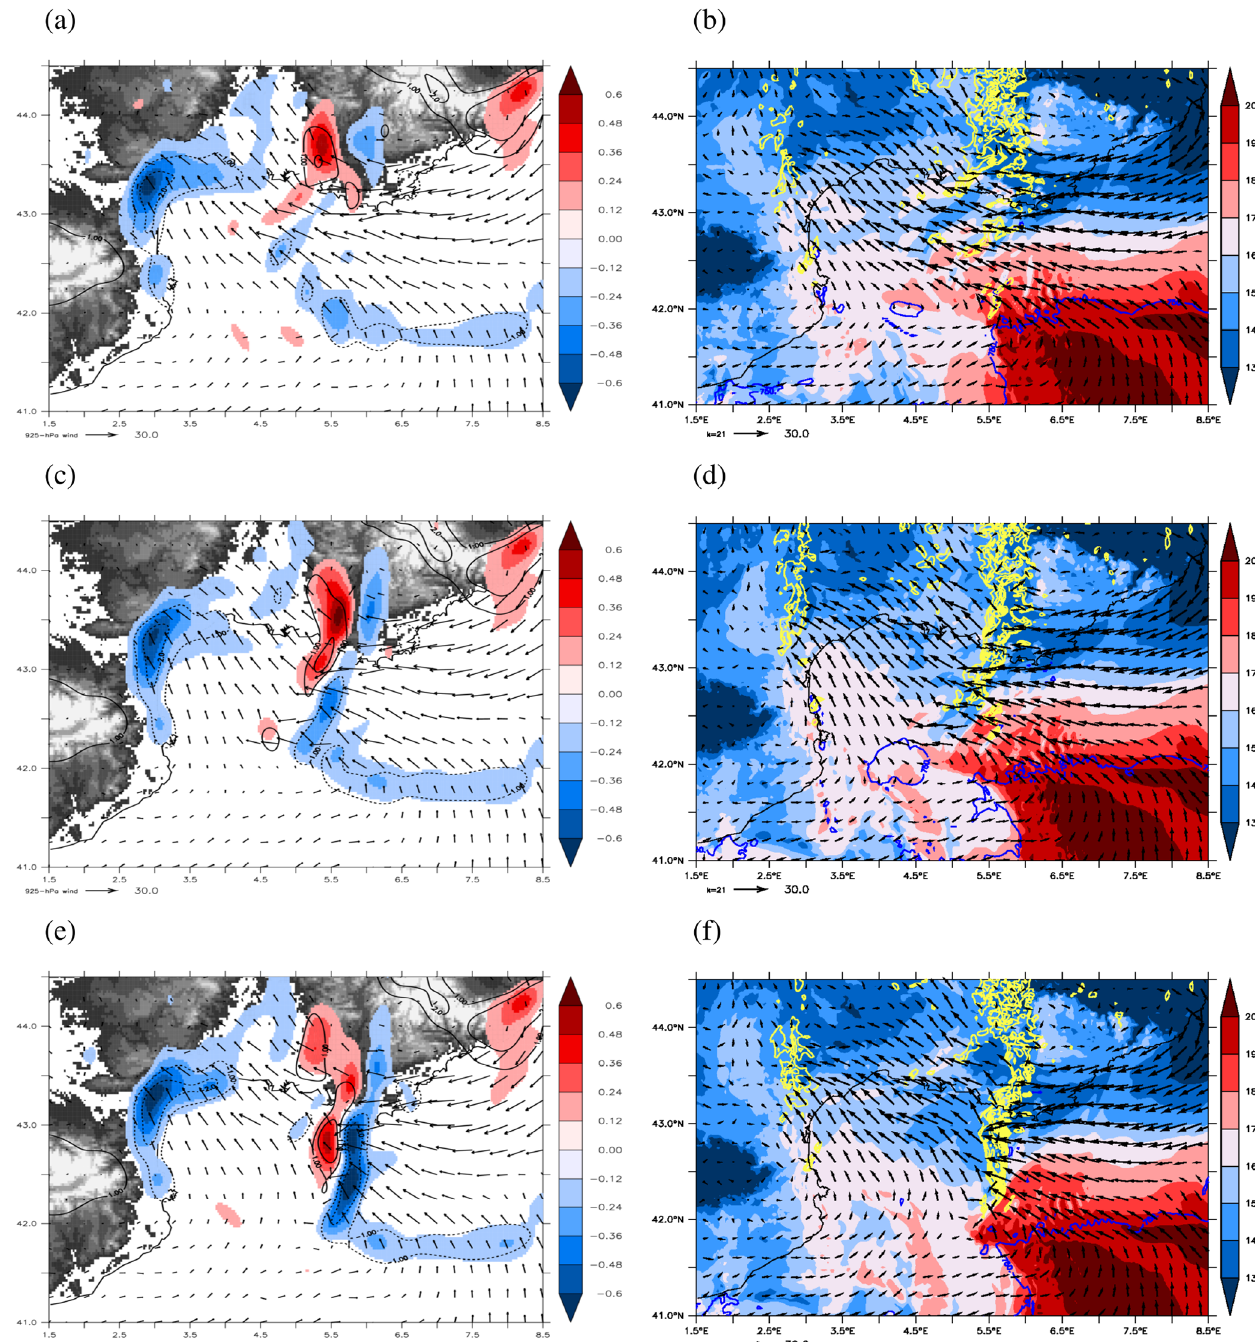
Figure 10. (a, c, e) Wind divergence (10 − 3 s − 1 ) at 950hPa, vertical velocity (Pa s − 1 , black contours) at 950hPa and surface wind at 925hPa (ms − 1 , arrows). (b, d, f) θ (cid:48) w at 925hPa ( ◦ C), CAPE ( > 750Jkg − 1 , dark blue line), and surface wind at 925hPa (ms − 1 , arrows) and reflectivities at 2000m (dBz, yellow line) at 00:00UTC on 14 October for (a, b) AYSSTatl, (c, d) AO and (e, f) AOW.